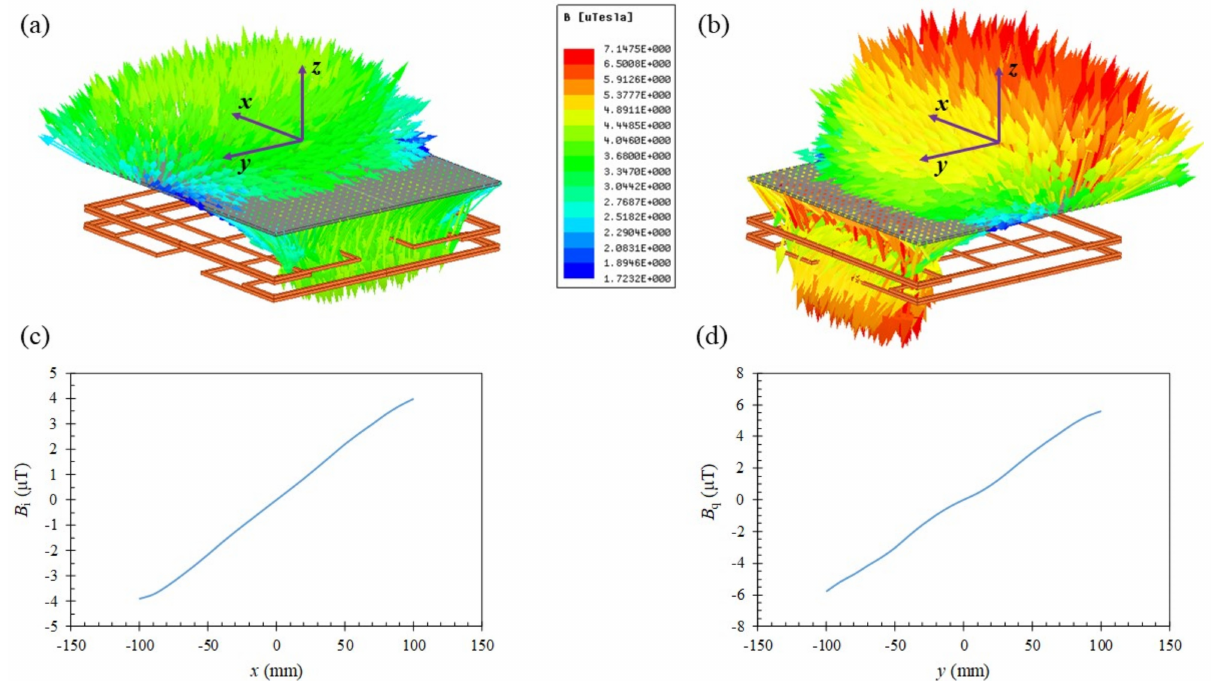
Figure 5. The simulated gradient magnetic field distribution on detection plane of ( a ) x -coil ( B i ), ( b ) y -coil ( B q ), ( c ) B i at y = 0, and ( d ) B q at x =